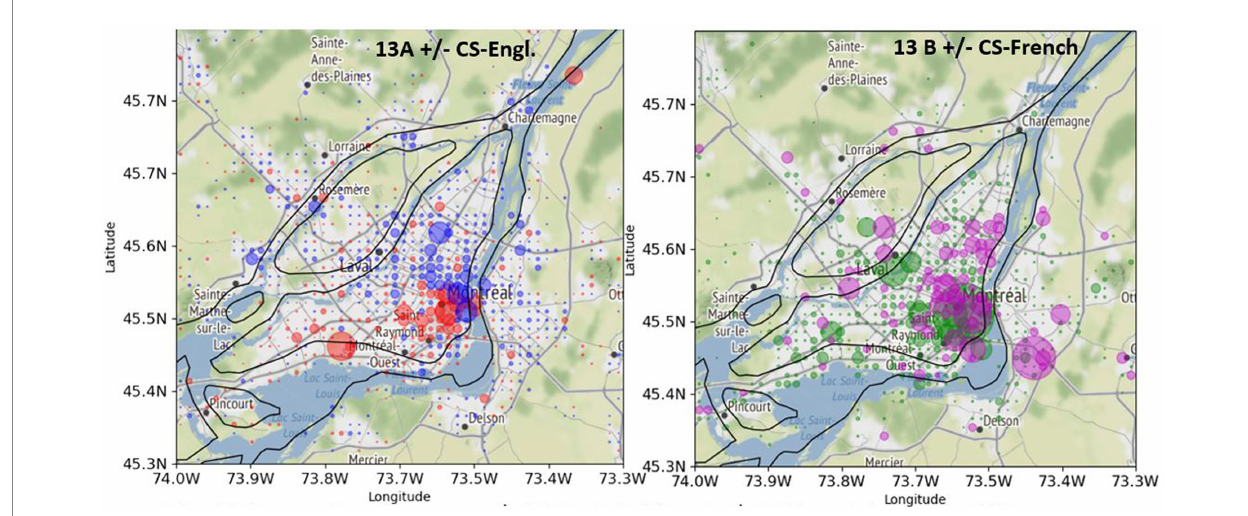
FIGURE 13 Comparison between +/ − CS-Engl. (left) and +/ − CS-French (right) in GM. ( A , left): +CS-Engl. (red) and –CS-Engl. (blue). ( B , right) + CS-French (purple) and –CS-French (green). Base map and data from OpenStreetMap and OpenStreetMap Foundation under the Open Database